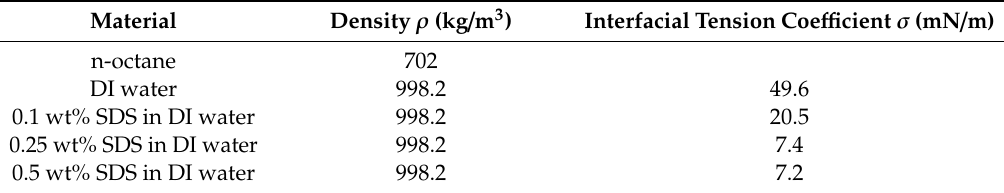
Figure 1. Experimental setup for droplet formation in buoyancy-assisted microfluidics. Table 1. The physical properties of all the